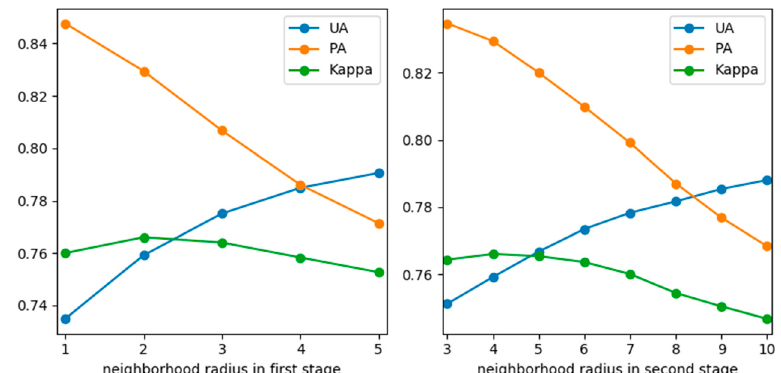
Figure 6. Extraction accuracy of urban extent under different neighborhood sizes: on the left is the different neighborhood sizes of the first stage (fixed neighborhood radius 4 in the second stage); on the right is the different neighborhood sizes of the second stage (fixed neighborhood radius 2 in the second stage).